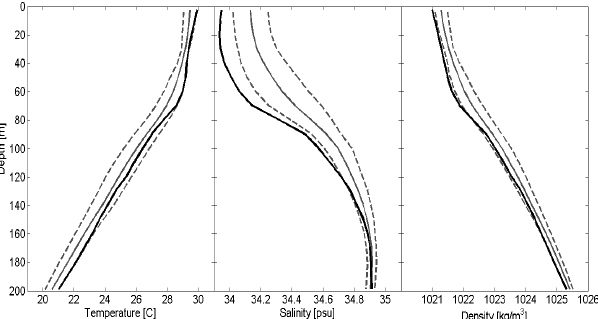
Figure 2. Monthly climatology of temperature, salinity and density from Argo-based climatology (Roemmich and Gilson, 2009) for the Fig.2. Monthly Climatology of temperature, salinity and density from Argo based climatology 3 1 degree × 1 degree grid centered at 17.5 ◦ N, 126.5 ◦ E. Solid grey ( Roemmich and Gilson 2009) for the 1×1 degree grid centered at 17.5N, 126.5E. Solid grey 4 line represents the mean value, and dashed grey lines represent de- viation from the mean (standard deviation). Solid black line shows line represents the mean value and dashed grey lines represent deviation from the mean 5 the September 2008 (standard deviation). Solid black line shows the September 2008 value. 6